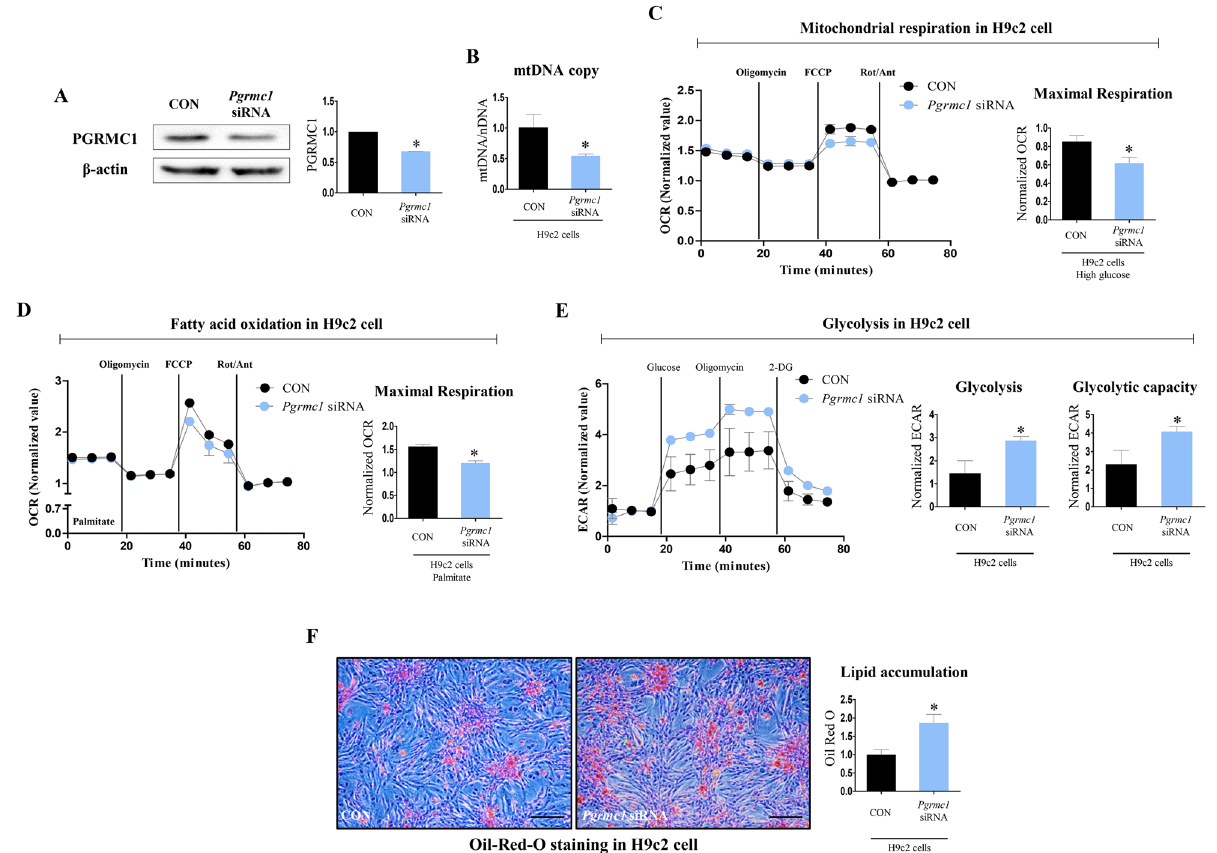
Figure 6. Pgrmc1 increases mitochondrial respiration and fatty acid oxidation in H9c2 cells. ( A ) Western blot analysis and quantification of PGRMC1 in H9c2 cells. β-Actin was used for an internal control. ( B ) Copies of mitochondrial DNA (mtDNA) in H9c2 cells. Nuclear DNA (nDNA) was used for an internal control. ( C ) Mitochondrial respiration measured by using flux analyzer in H9c2 cells. Values were normalized to baseline. ( D ) Glycolysis rate measured by using flux analyzer in H9c2 cells. Values were normalized to baseline. ( E ) Fatty acid oxidation rate measured by mitochondrial stress test using flux analyzer in palmitate-BSA treated condition in H9c2 cells. Values were normalized to baseline. ( F ) Oil-Red-O staining in palmitate-BSA treated condition in H9c2 cells (scale bar 100 µm). Positive area was measured by Image J program. Red area was set as positive. Values represent means ± SD. *p < 0.05. Student’s t test was performed. All experiments were repeated at least